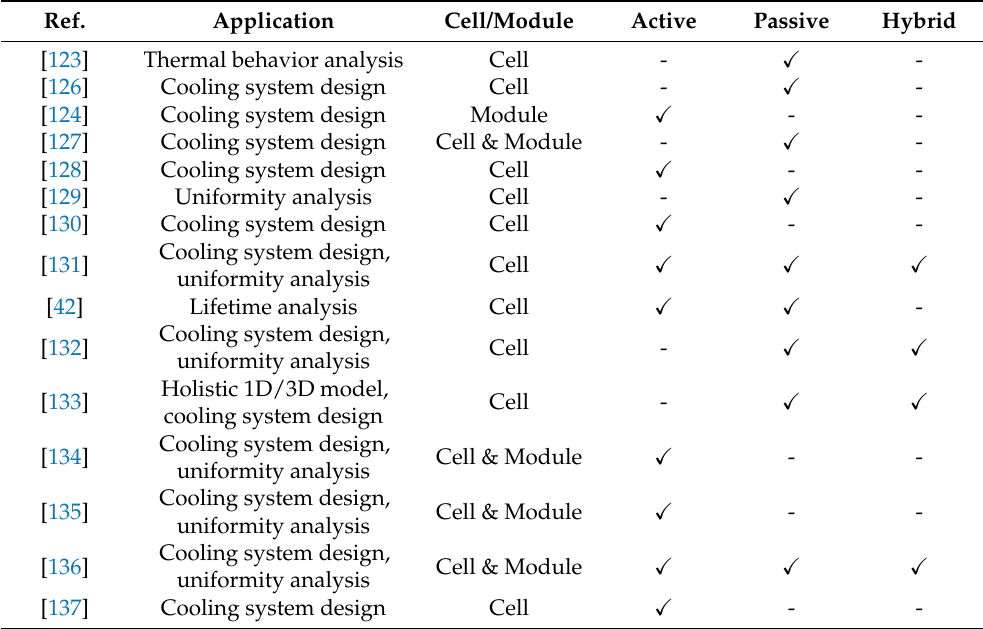
Table 1. The developed 3D models for LiCs in the literature with their type of TMS.